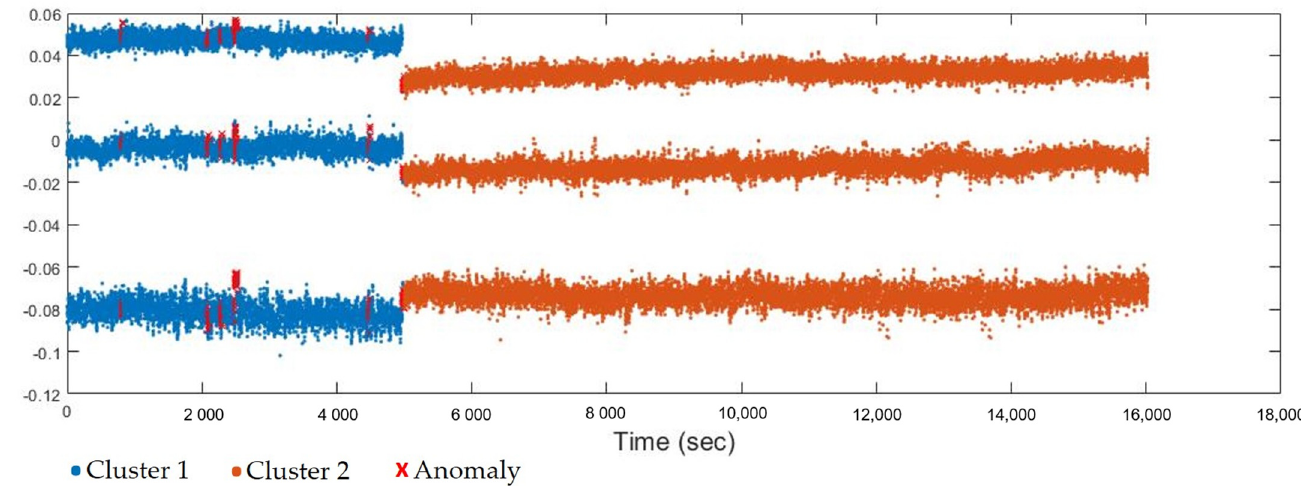
Figure 9. Novelty detection for the condition recognition .